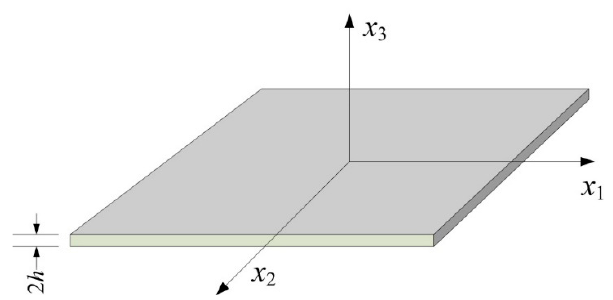
Figure 1. Free-plate schematic showing geometry.